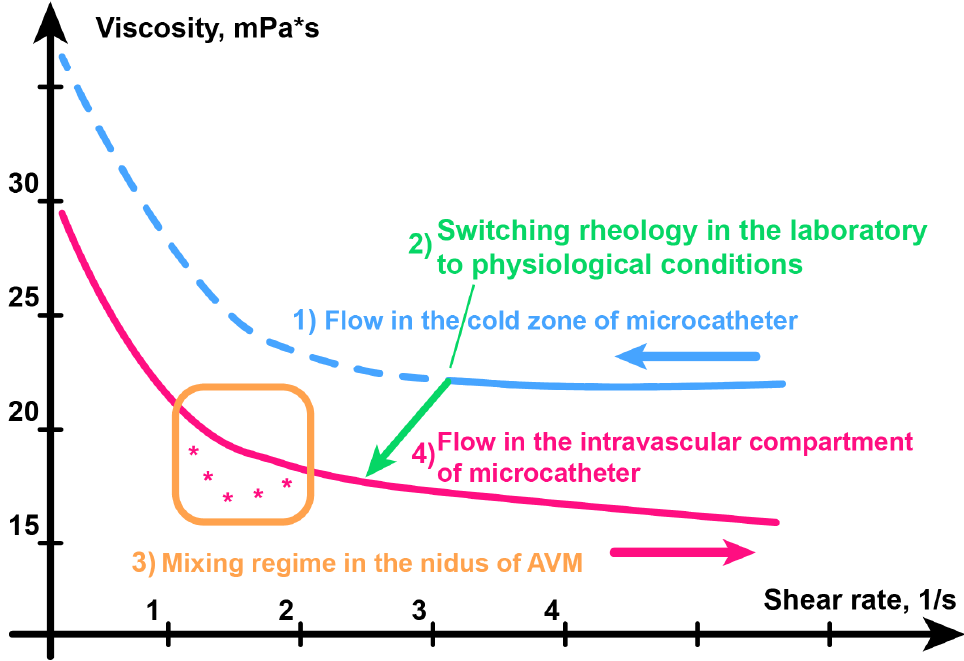
Figure 17. Viscosity change mechanism during